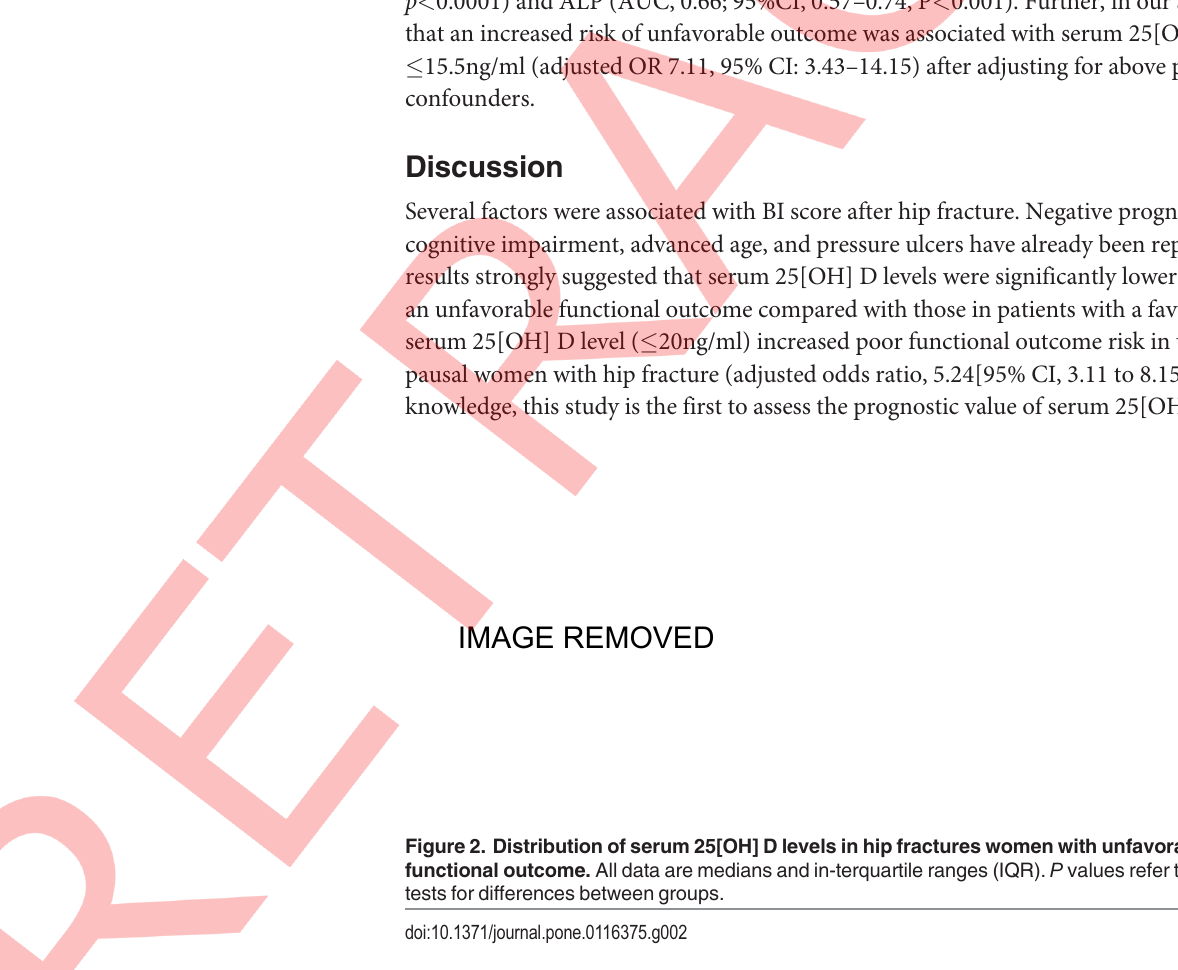
Figure 2. Distribution of serum 25[OH] D levels in hip fractures women with unfavorable and favorable functional outcome. All data are medians and in-terquartile ranges (IQR). P values refer to Mann-Whitney U tests for differences between